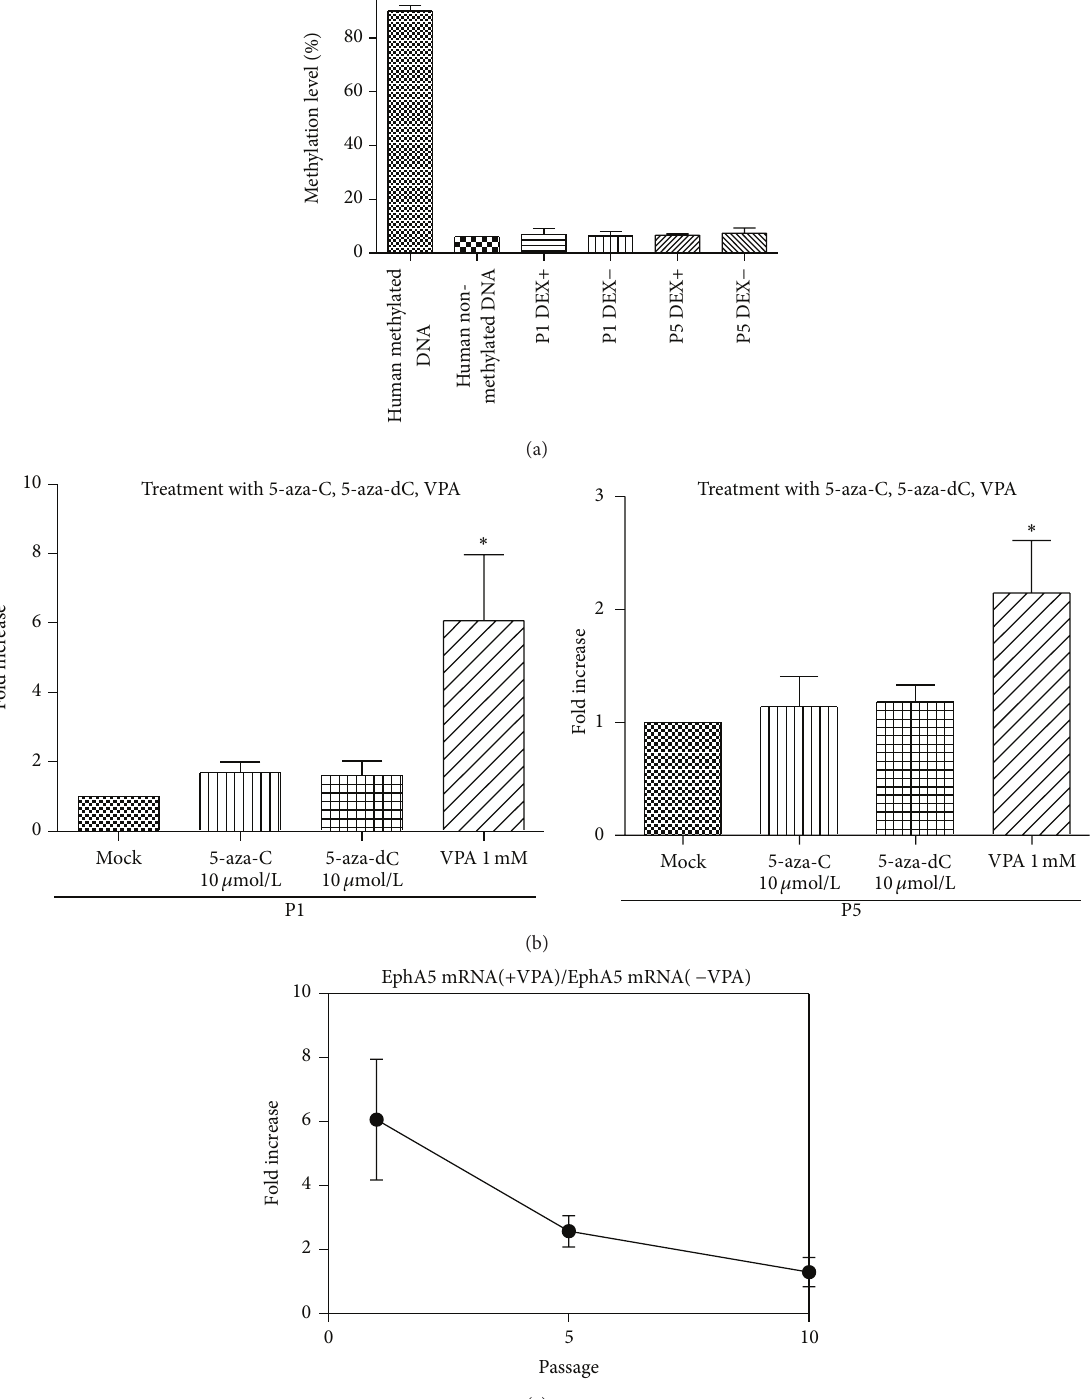
Figure 4: Silencing of EphA5 in early-passage hBMSCs is not associated with aberrant hypermethylation of the EphA5 promoter. (a) The methylationlevelfortheEphA5promoterthatcontainstwoMethylation-SensitiveRestrictionEnzymes(MSRE)siteswasdetermined( 𝑛 = 4 ). Themethylation level fortheEphA5 promoterinhBMSCsatP1andP5 wasmuch lower thanthatin humanmethylated DNAusedasa